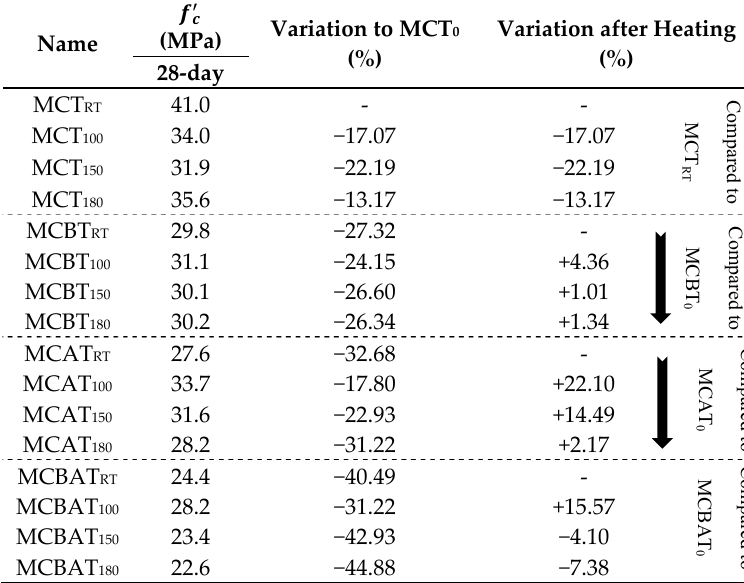
Table 7. Compressive strength for the cement concrete.